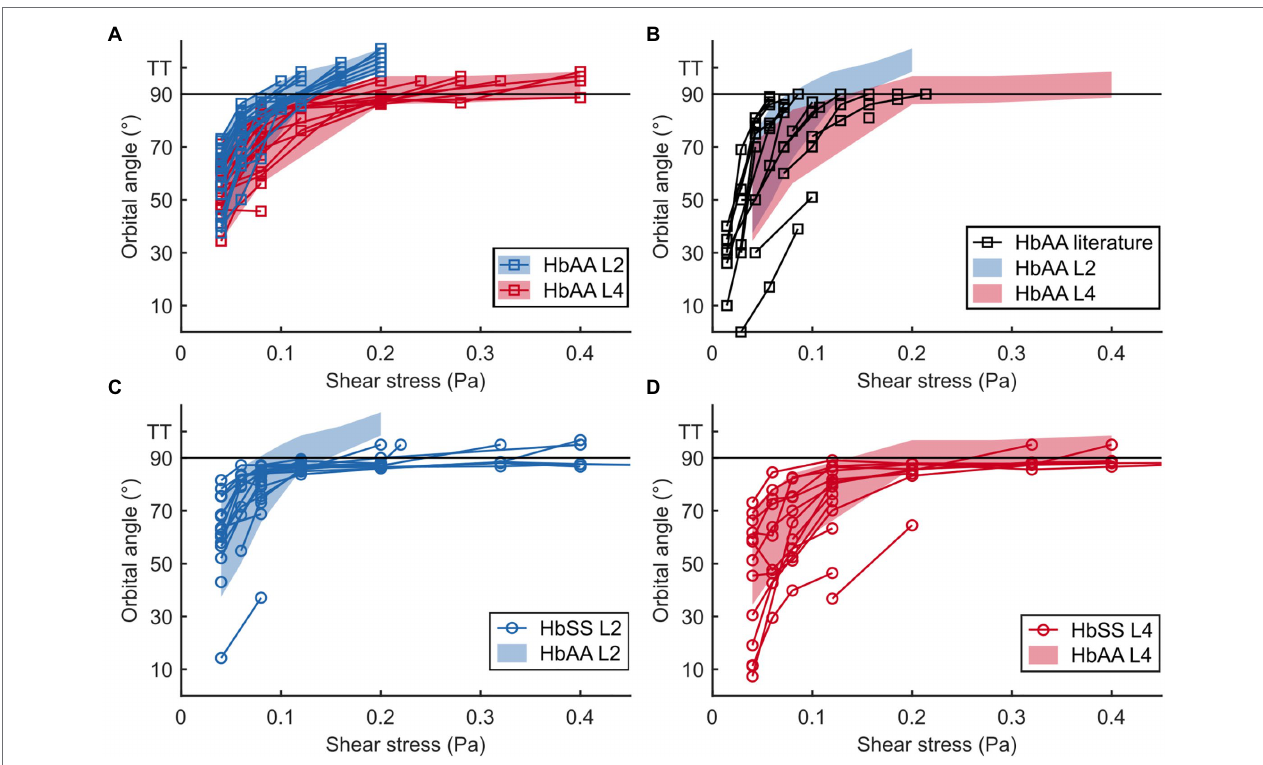
FIGURE 4 | The flip-flopping regime is similar in healthy and SCD samples but the transition to tank-treading regime is delayed for SCD RBCs. (A,B) Evolution of the orbital angle ϕ vs. shear stress ηγ  0 for L2 and L4 layers of a healthy sample (HbAA; A ) and comparison with data found in literature (B) . L2 and L4 data in (A) are highlighted with color-shaded regions (blue and red, respectively) to facilitate comparison with other data sets. (C,D ) Orbital angles for L2 (C) and L4 (D) layers of an SCD sample (HbSS) compared to those of the HbAA shown in (A) . At least 14 RBCs were tracked in each sample. For all samples, tank-treading RBCs (TT, no ϕ value) are artificially scattered above the line drawn at 90 ° for clarity. The tank-treading regime was not characterized in the literature